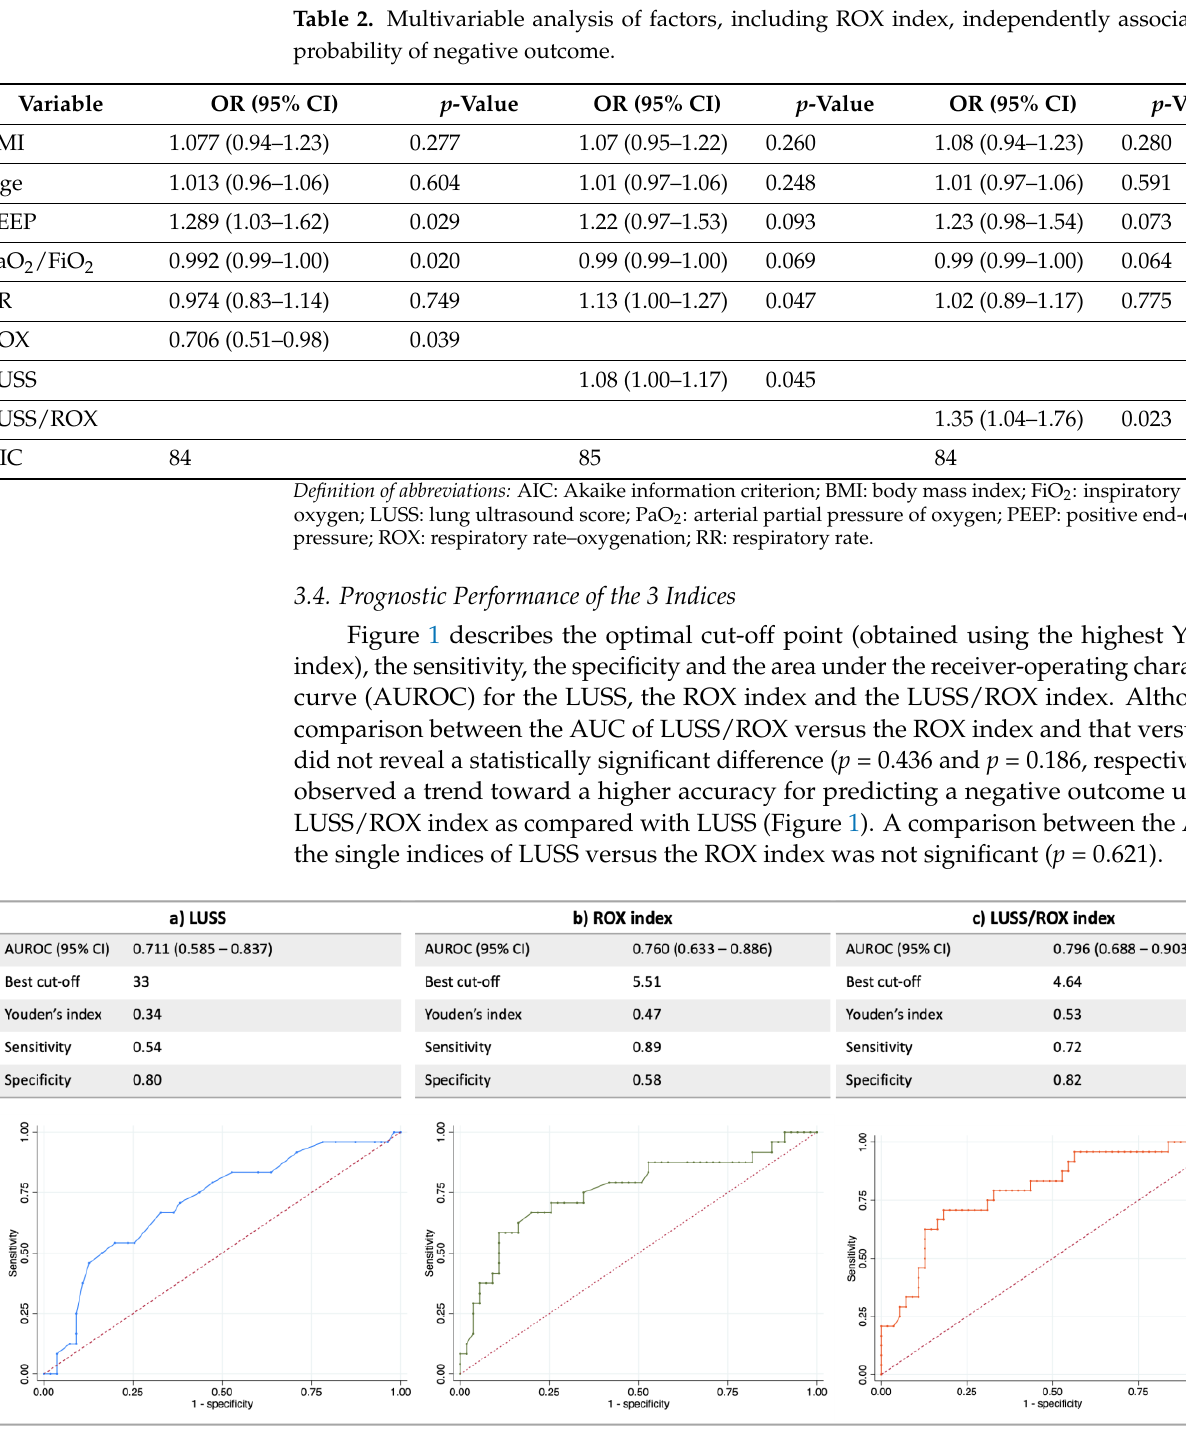
Figure 1. AUROC, best cut-off, sensitivity and specificity of LUSS ( a ), ROX ( b ) and LUSS/ROX ( c ) in predicting the composite outcome of endotracheal intubation and mortality. Definition of abbreviations: AUROC: area under the receiver-operating characteristic curve; LUSS: lung ultrasound score; ROX: respiratory rate – oxygenation.